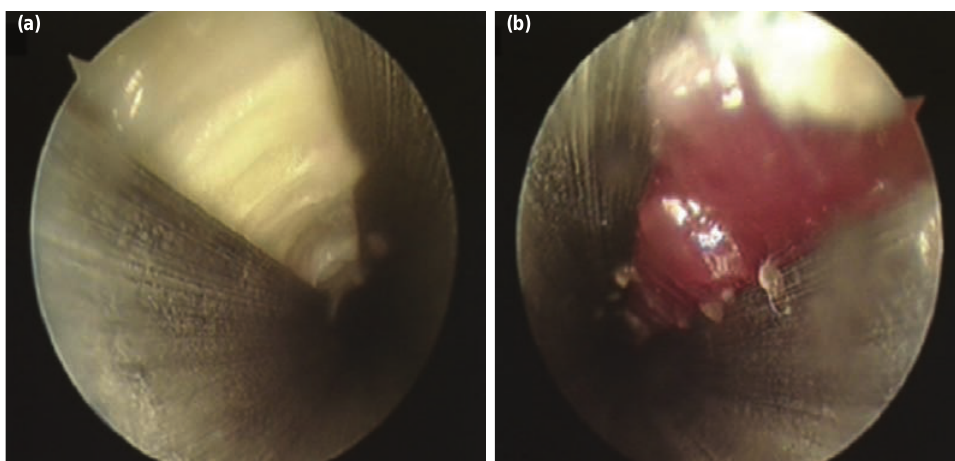
Endoscopic view (a) Intact plantar fascia prior to release, (b) after medial released. Intrinsic muscles left Fig. 6: